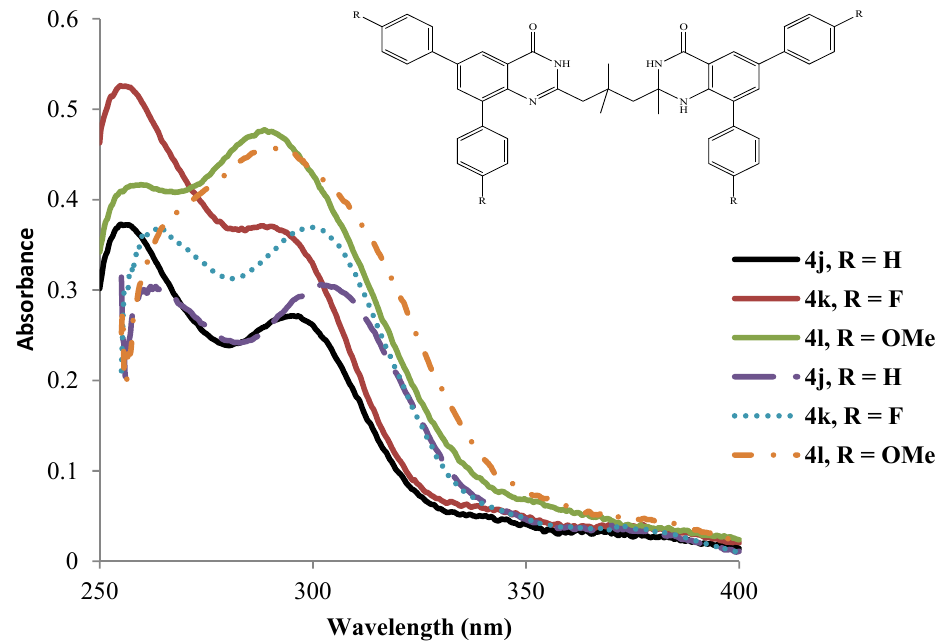
Figure 5. UV-Vis spectra of 4j – l in DMSO (dashed lines) and CH (conc. = 1.0 × 10 − 5